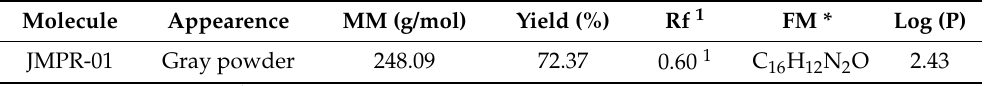
Table 1. Physicochemical characteristic of the phenylacrylamide derivative JMPR-01. Molecule